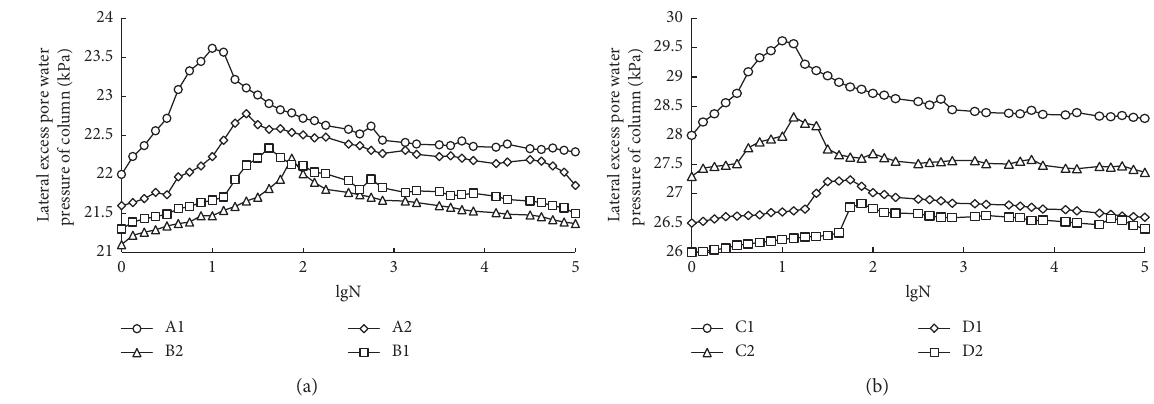
Figure 9: Lateral superpore water pressure of the column: (a) CLR � 0.2 and CLR � 0.3; (b) CLR � 0.4 and CLR �